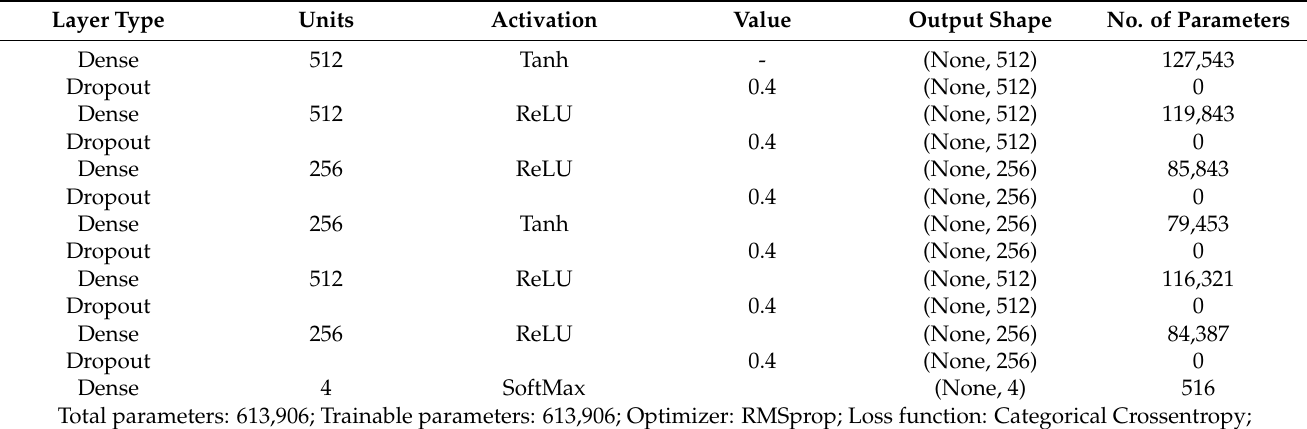
Table 7. DNN Optimal structure for the variables set